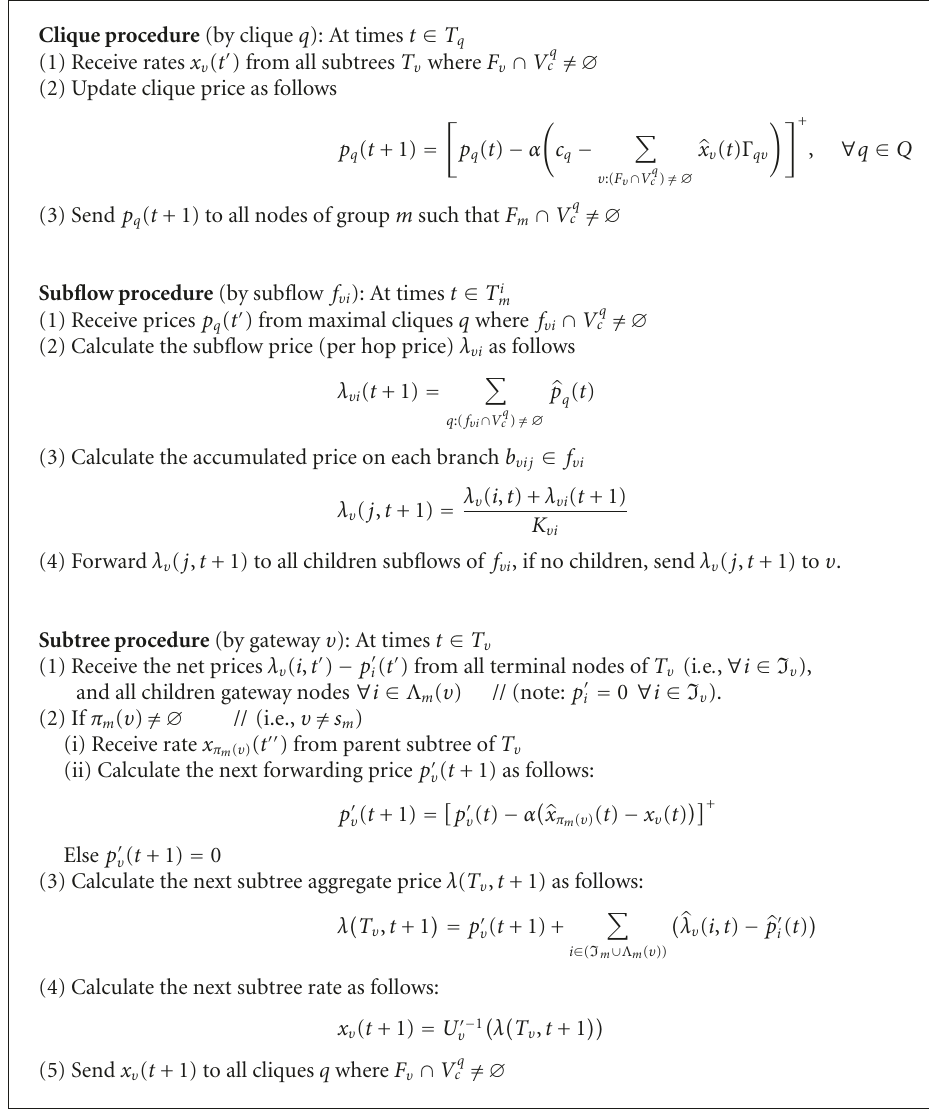
Algorithm 1: ORAHWM: asynchronous distributed algorithm.